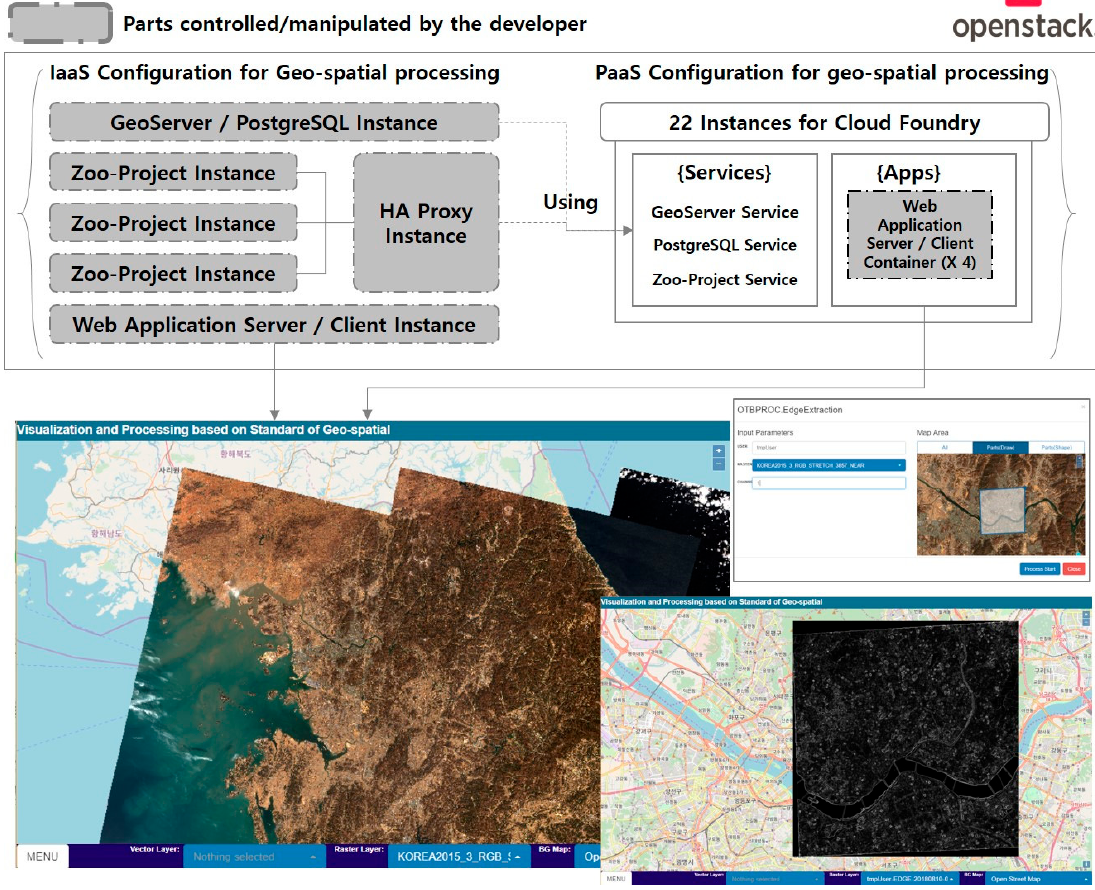
Figure 3. Configuration of the test case of the geo-spatial image processing service implemented in this study and an example of the processed result.